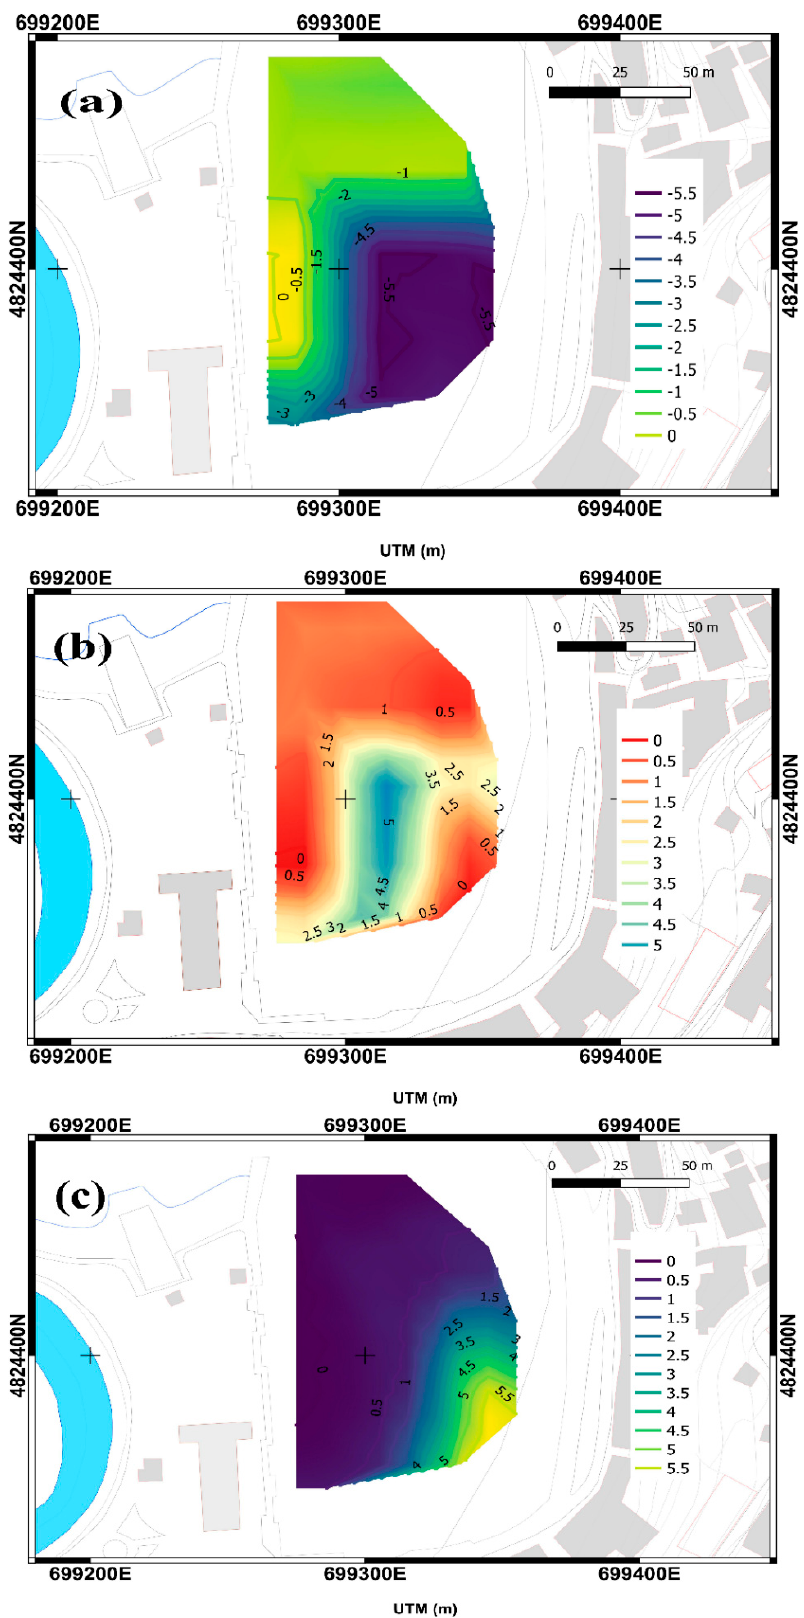
Figure 7. Difference in elevation of the bathymetries in the Port of Luarca between ( a ) 16/11/18 and 31/12/18, ( b ) 31/12/18 and 05/01/19, and ( c ) 05/01/19 and 24/02/19.